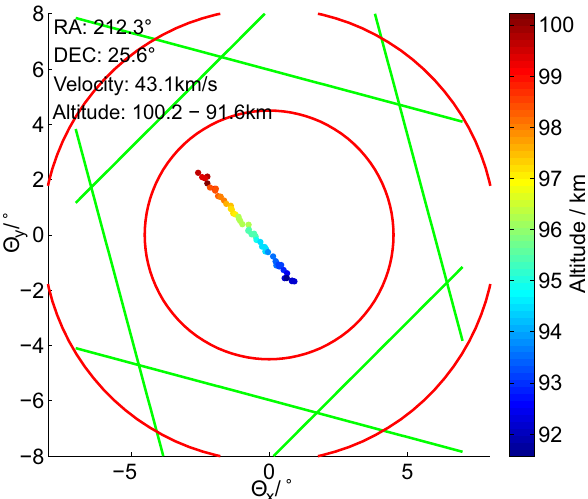
Fig. 2. Example of a typical meteor-head echo, Figs. 2–6 are related to the same echo.